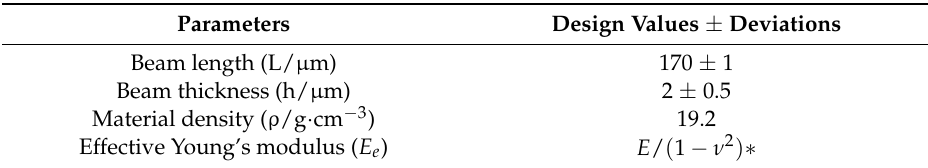
Table 1. Relative parameters in Equation (9).